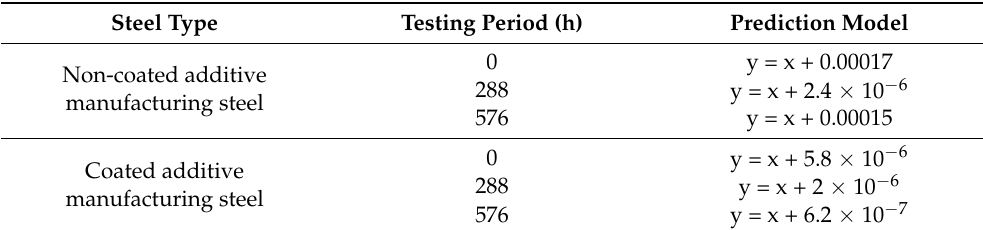
Table 2. Prediction model for the real and imaginary impedance of coated and non-coated manufac- turing steel at several testing periods.